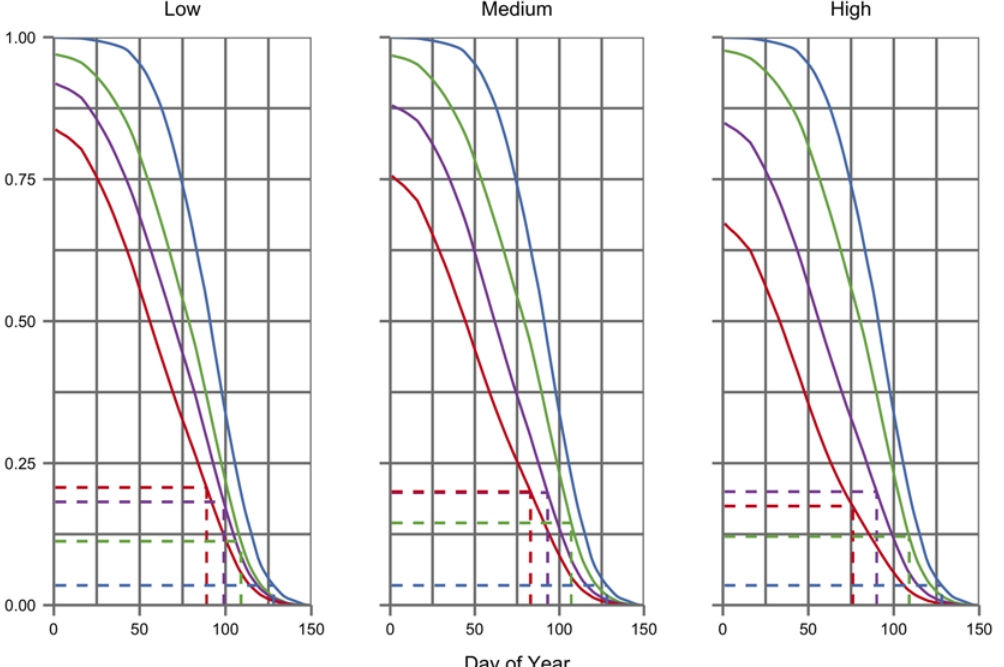
Fig 4. Spring frost risk profiles under baseline (blue) and three future time periods (green 2010 – 39, purple 2040 – 69, red 2070 – 89) for low, medium and high emissions scenarios (from left to right). Dotted lines indicate the mean budbreak date, calculated using a spring warming model [58], and the corresponding risk of a later frost under each scenario and time